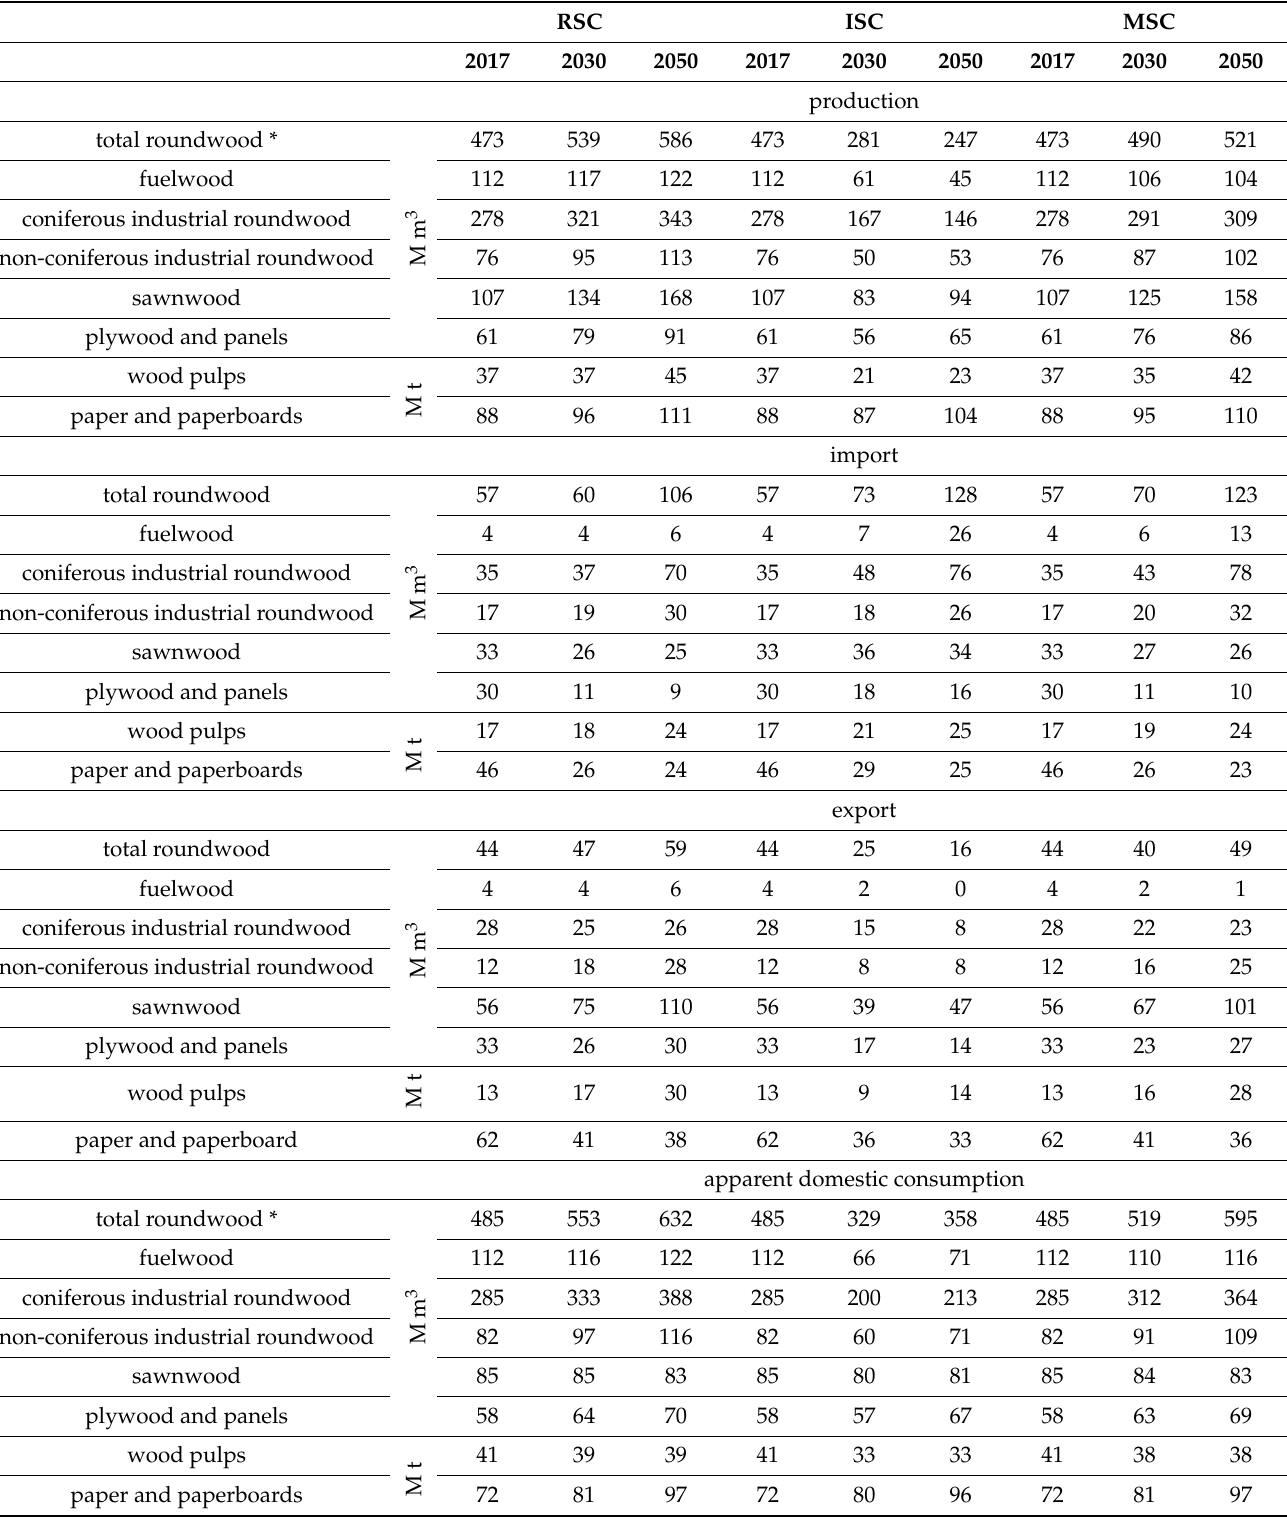
Table A7. Development of EU production, import and exports (M m 3 , M t) of wood and wood-based products in the reference, intensive and moderate scenario [authors’